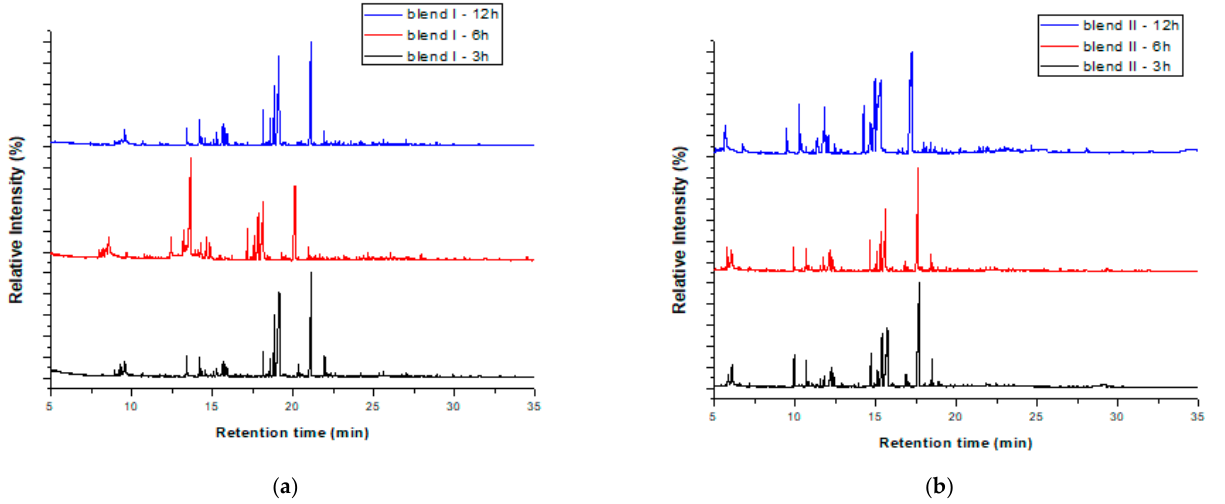
Figure 7. GC/MS chromatograms after pyrolysis of the blends after soxhlet extraction with isopropanol for 3, 6 and 12 h for blend I ( a ) and blend II ( b ).